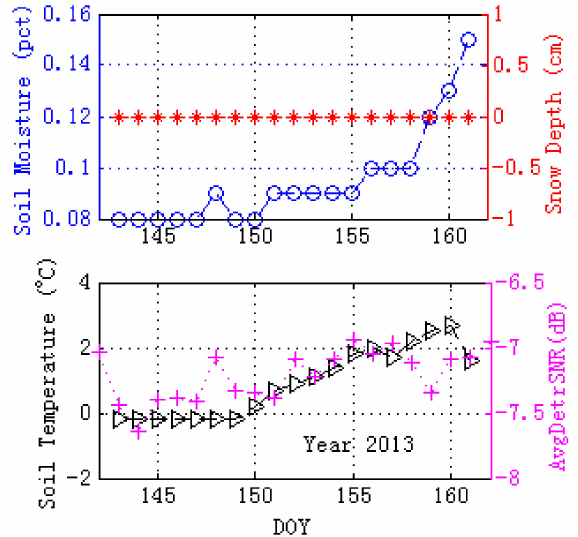
Figure 10. Comparisons between GPS site (AB33) and SNOTEL site (ID 958) from DOY 142 (2013) to DOY 162 (2013). The elevation angle is 20 ◦ . The upper panel presents the comparisons of soil moisture (blue O) and snow depths (red *). Comparisons of soil temperature (black (cid:52) ) and ADSNR (pink +) are presented in the bottom